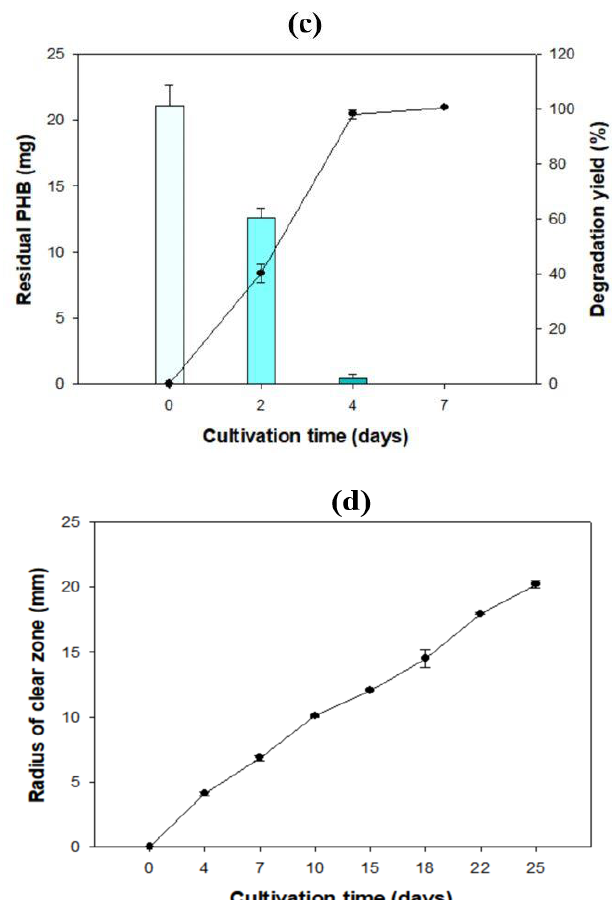
Figure 1. Superior poly(3-hydroxybutyrate) (PHB) degrading activity of Microbulbifer sp. SOL66. ( a ) The PHB degradation yields of 5 strains of Microbulbifer were measured using a liquid-based method. The residual PHB (mg) measured by gas chromatography is presented on the left axis, and the degradation yield (%) calculated by comparing the residual PHB (mg) to the original amount of PHB is presented on the right axis. ( b ) The phylogenetic tree is based on the sequence of the 16S rRNA. ( c ) Degradation yield (%) of Microbulbifer sp. SOL66 measured over 7 d. ( d ) The Microbulbifer sp. SOL66 cells were cultured on solid MB medium with emulsified PHB at 37 °C. Table 1. Strains used in this experiment.